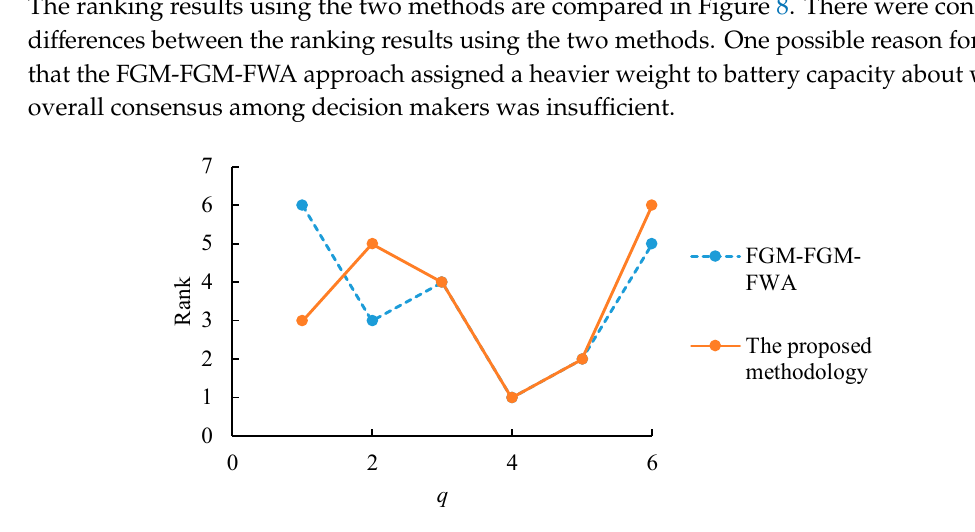
Defuzzified Overall Performance Asus ZenPower 10,000